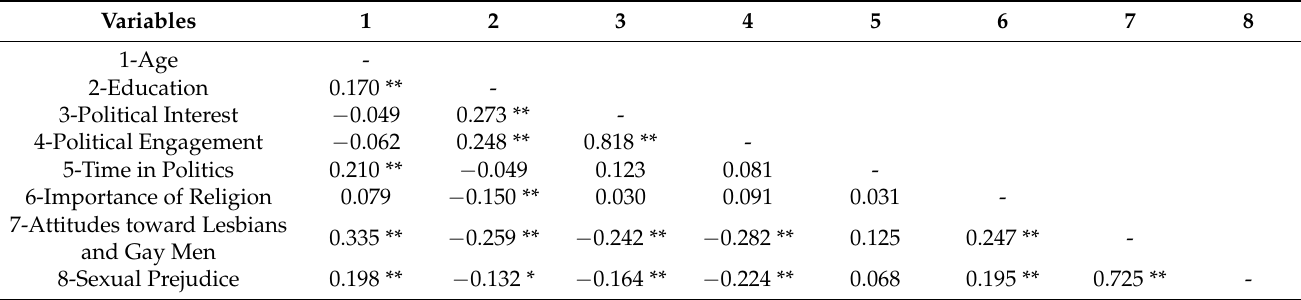
Table 8. Results for the correlation matrix between sexual prejudice and other